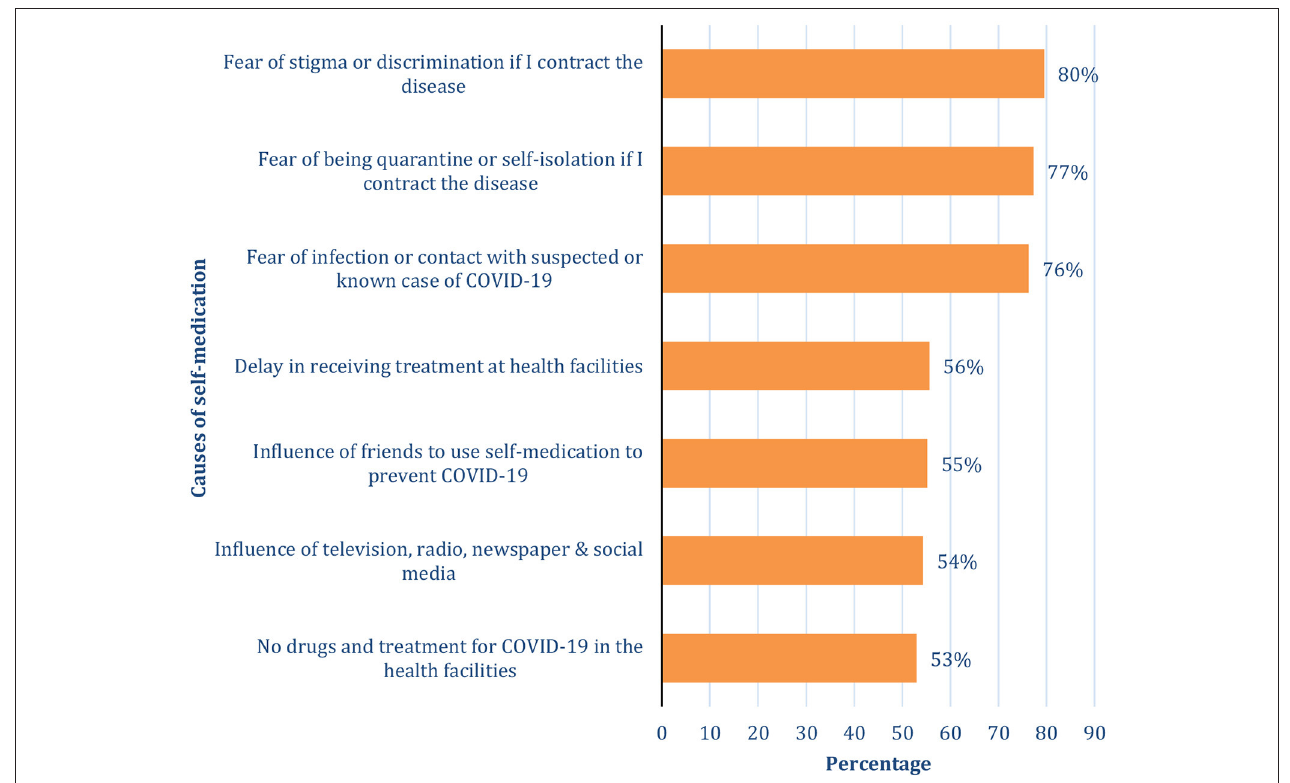
FIGURE 1 | Causes of self-medication among the respondents.